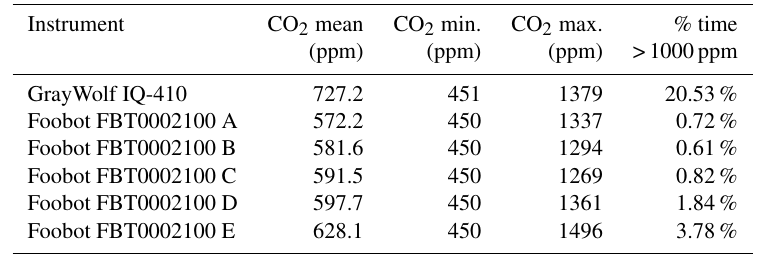
Figure 5. Total volatile organic compound levels from 29 August to 1 September 2017 form the Foobot and GrayWolf instruments. (Activity describes the morning routine: showering, grooming, and changing.) Table 4. Summary statistics for CO 2 calibration dataset divided by